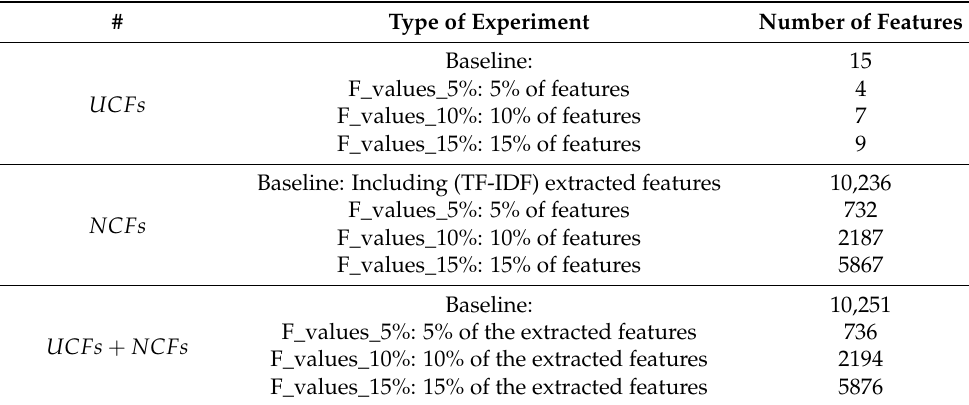
Table 8. Number of features per each